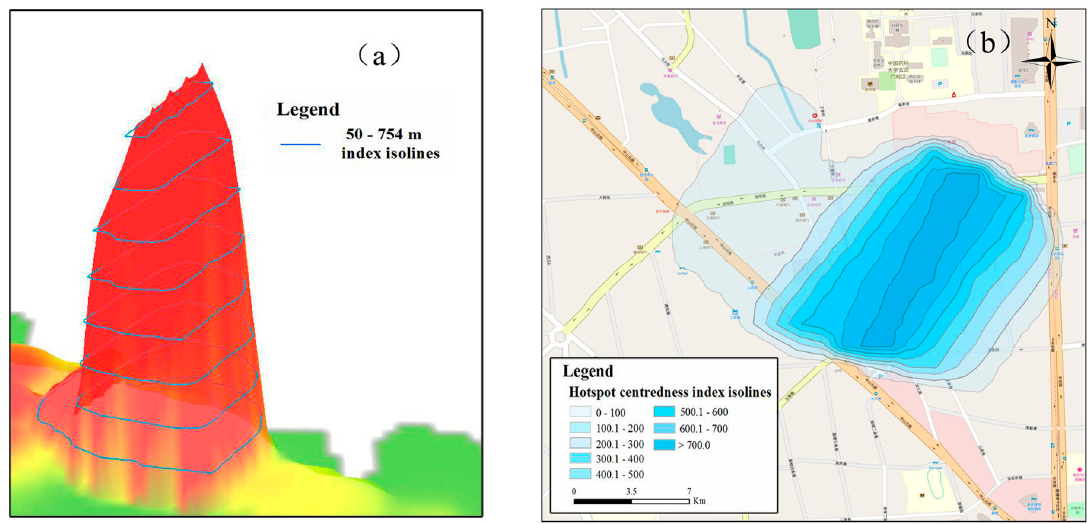
Figure 9. Isolines of hotspot concentration index produced by the network-based spatotemporal field clustering (NSF) approach, results presented based on ( a ) 3D and ( b ) 2D centredness surface.